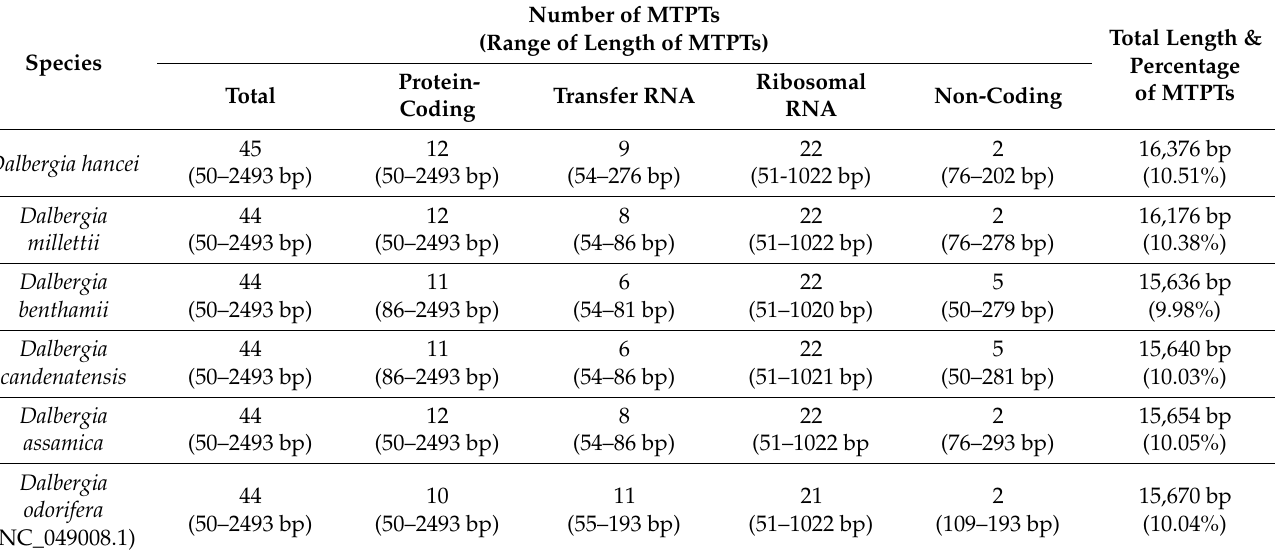
Figure 4. Sliding window analysis of 46 Dalbergia cp genomes. Table 3. Summary of mitochondrial plastid DNAs identified in the five Dalbergia cp